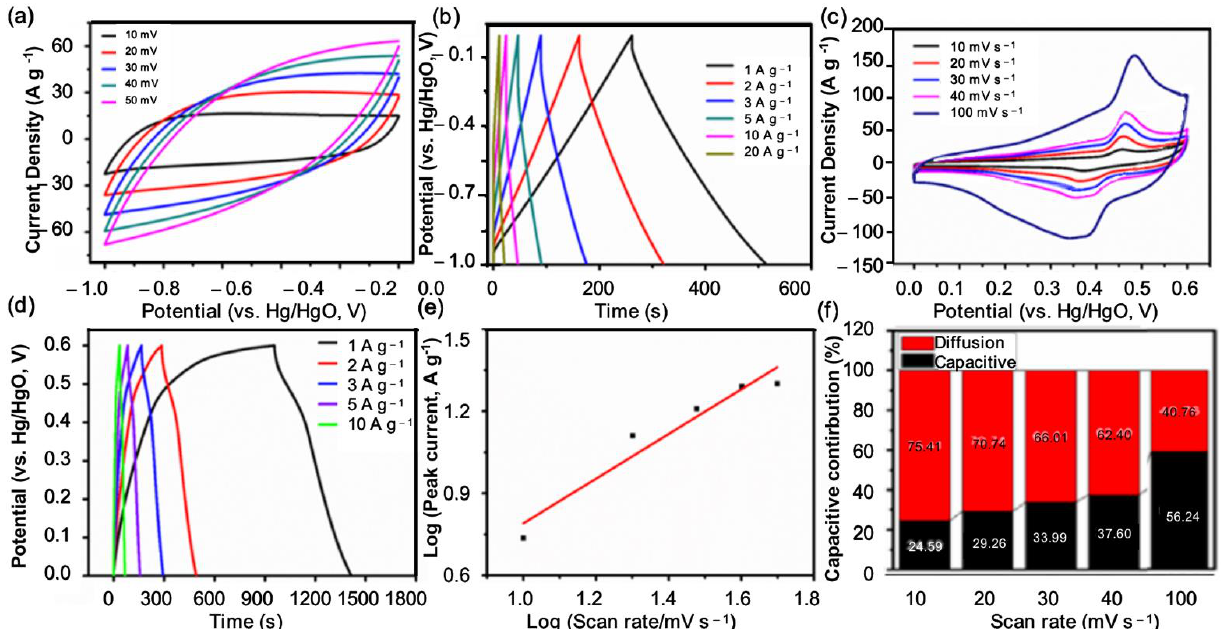
Figure 3. CV ( a ) and GCD ( b ) curves of NCW; CV ( c ) and GCD ( d ) curves of NCNS – NCW; ( e ) square root of scan rate and current density of NCNS – NCW; and ( f ) standardized contribution ratio of capacitance capacity at different scanning rates.